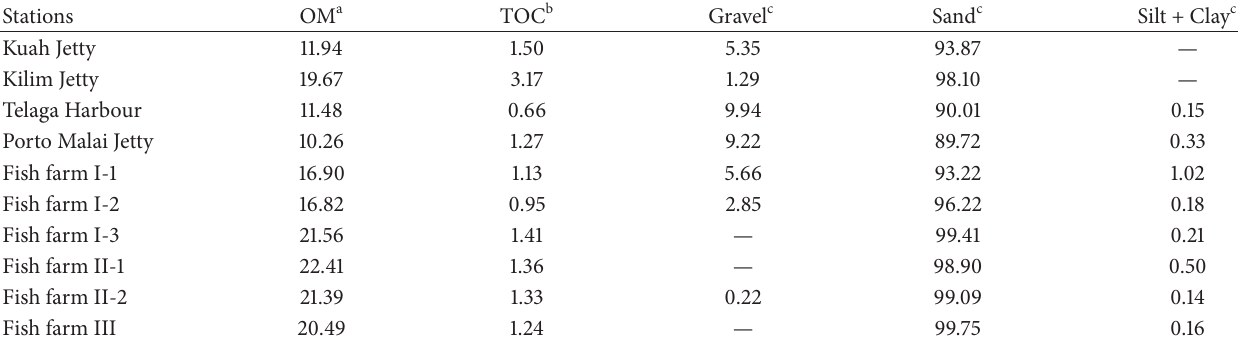
Table 3: TOC, OM, and grain size of sediments from Langkawi Island (values are in percentage). Stations OM a TOC b Gravel c Sand